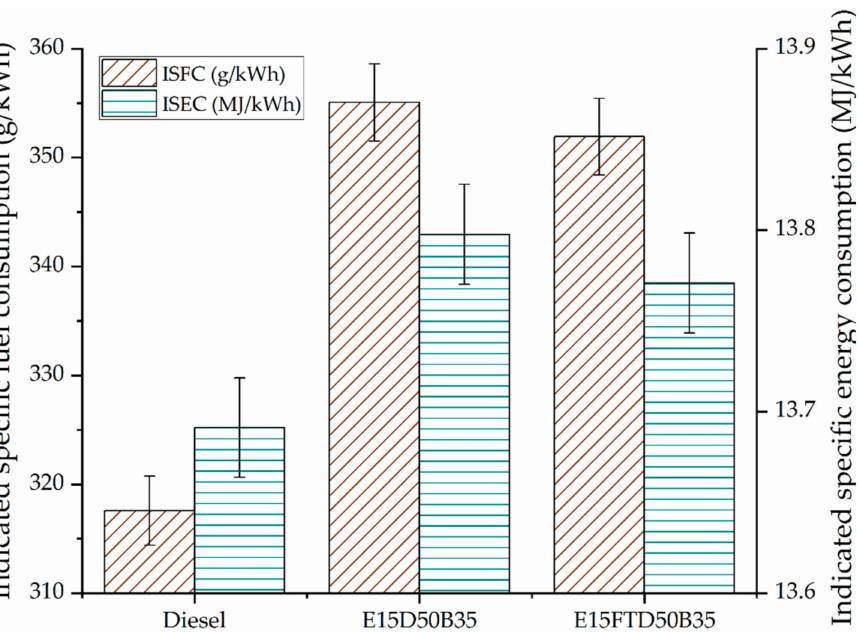
Figure 2. Indicated specific fuel consumption (ISFC) and indicated specific energy consumption (ISEC) for diesel, E15D50B35, and